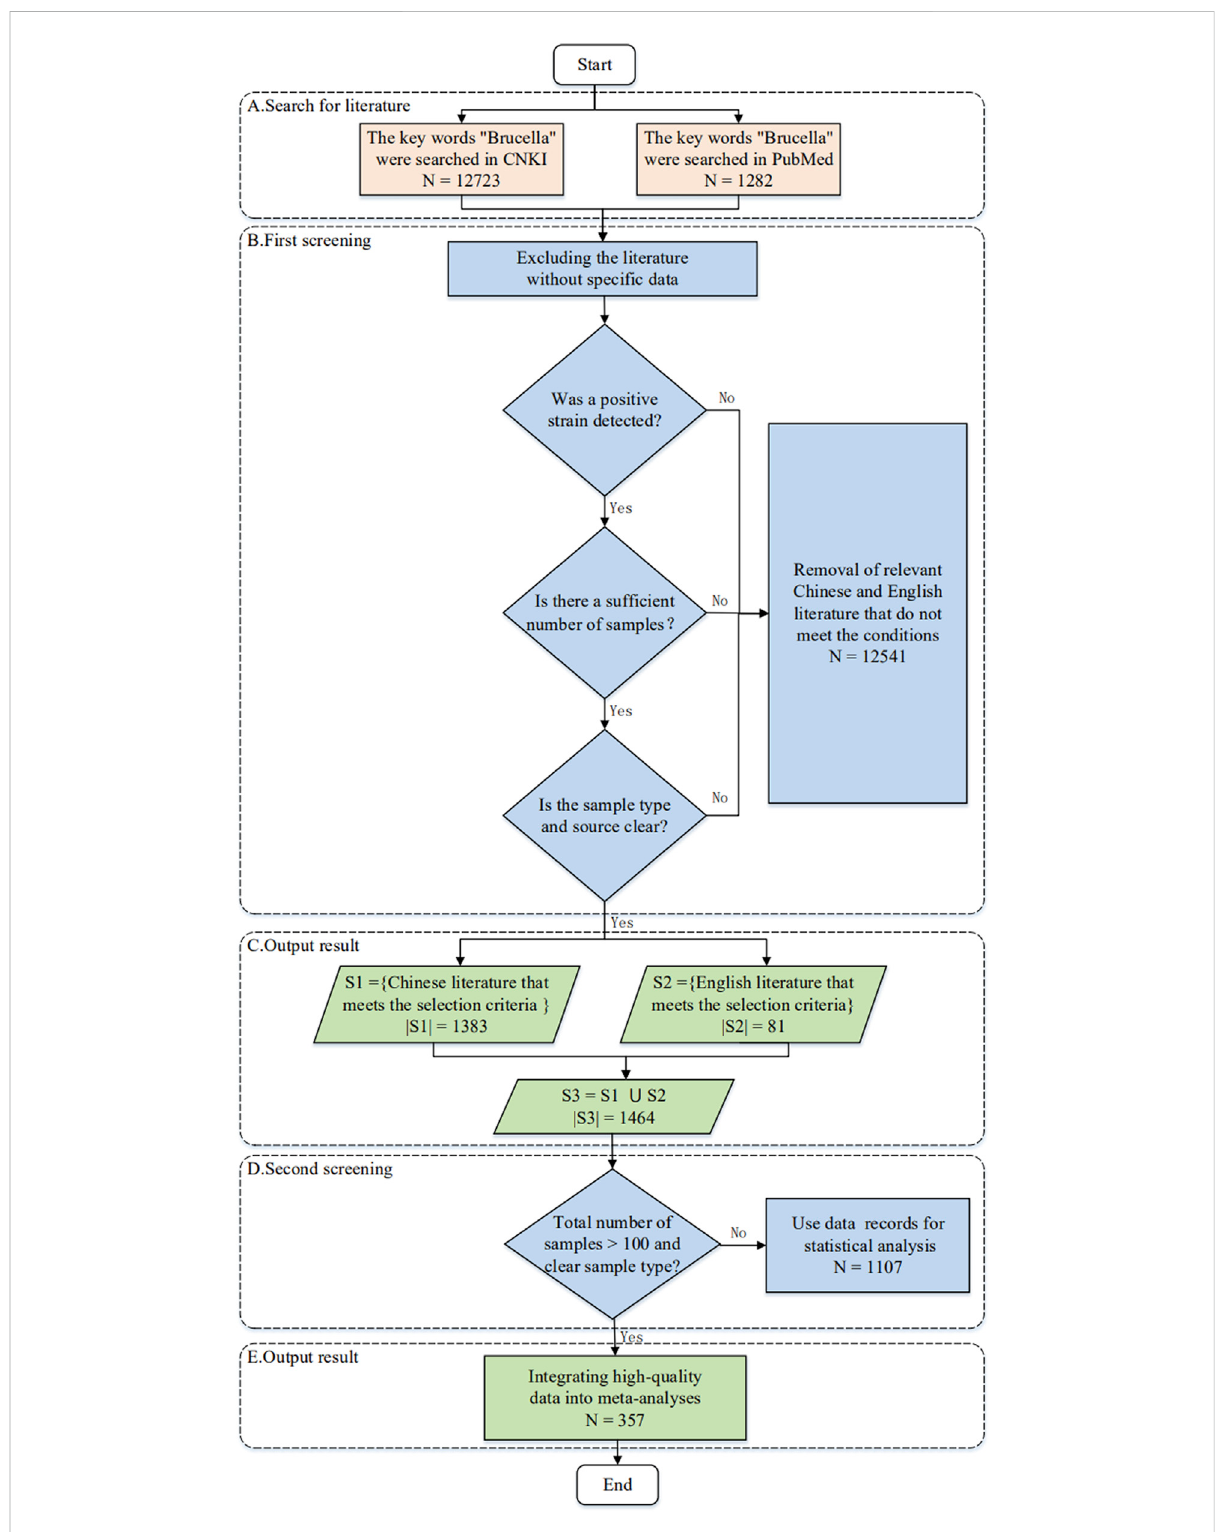
FIGURE 2 Flow chart for literature